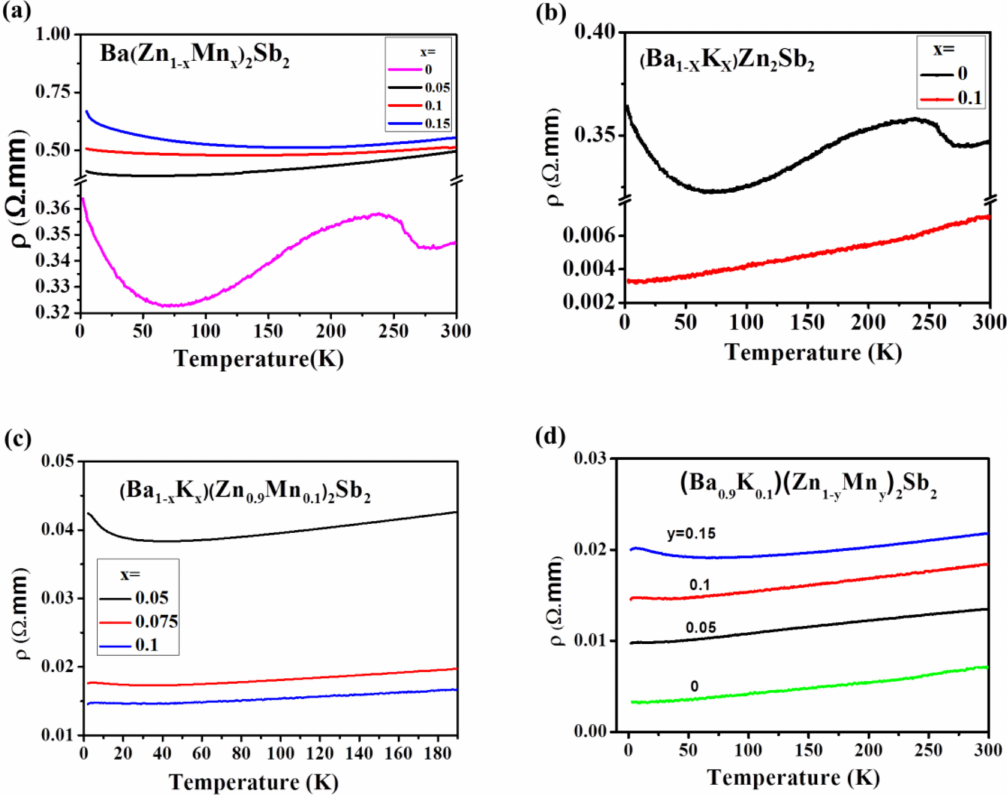
Figure 2. Temperature-dependent resistivity curves of ( a ) Ba(Zn 1 − y Mn y ) 2 Sb 2 (y = 0,